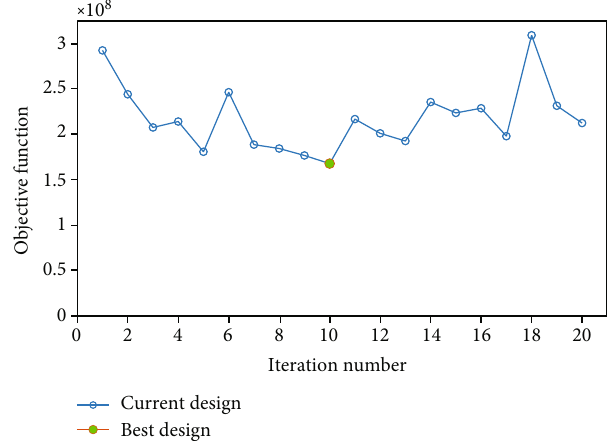
Figure 13: Objective function vs. number of iterations.